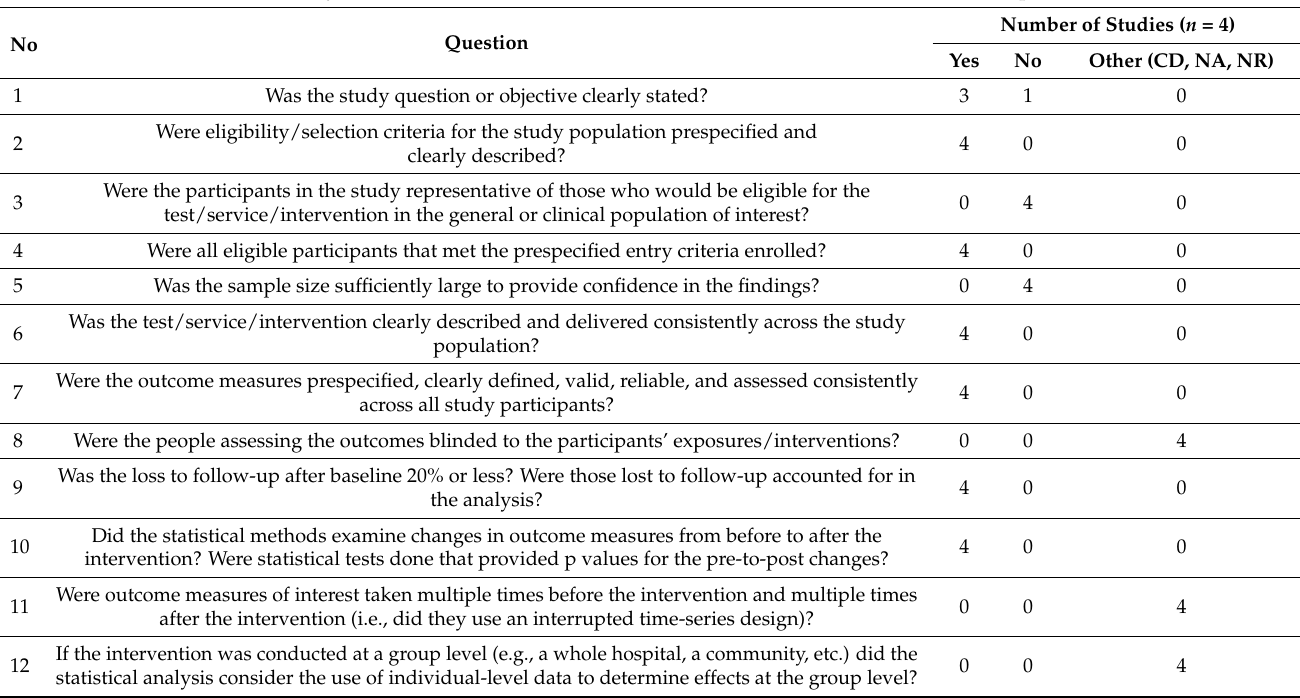
Table 3. Quality Assessment of Before-After (Pre-Post) Studies with No Control Group Studies through National Heart, Lung, and Blood Institute (NHLBI) quality assessment